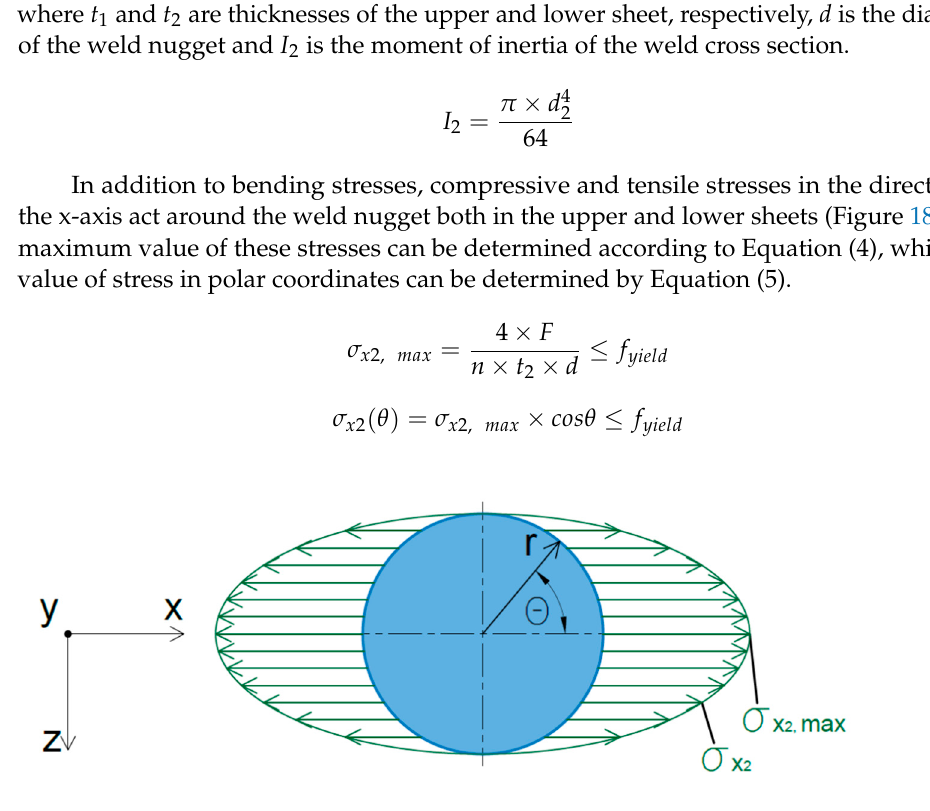
Figure 17. Stresses acting on the weld nugget.